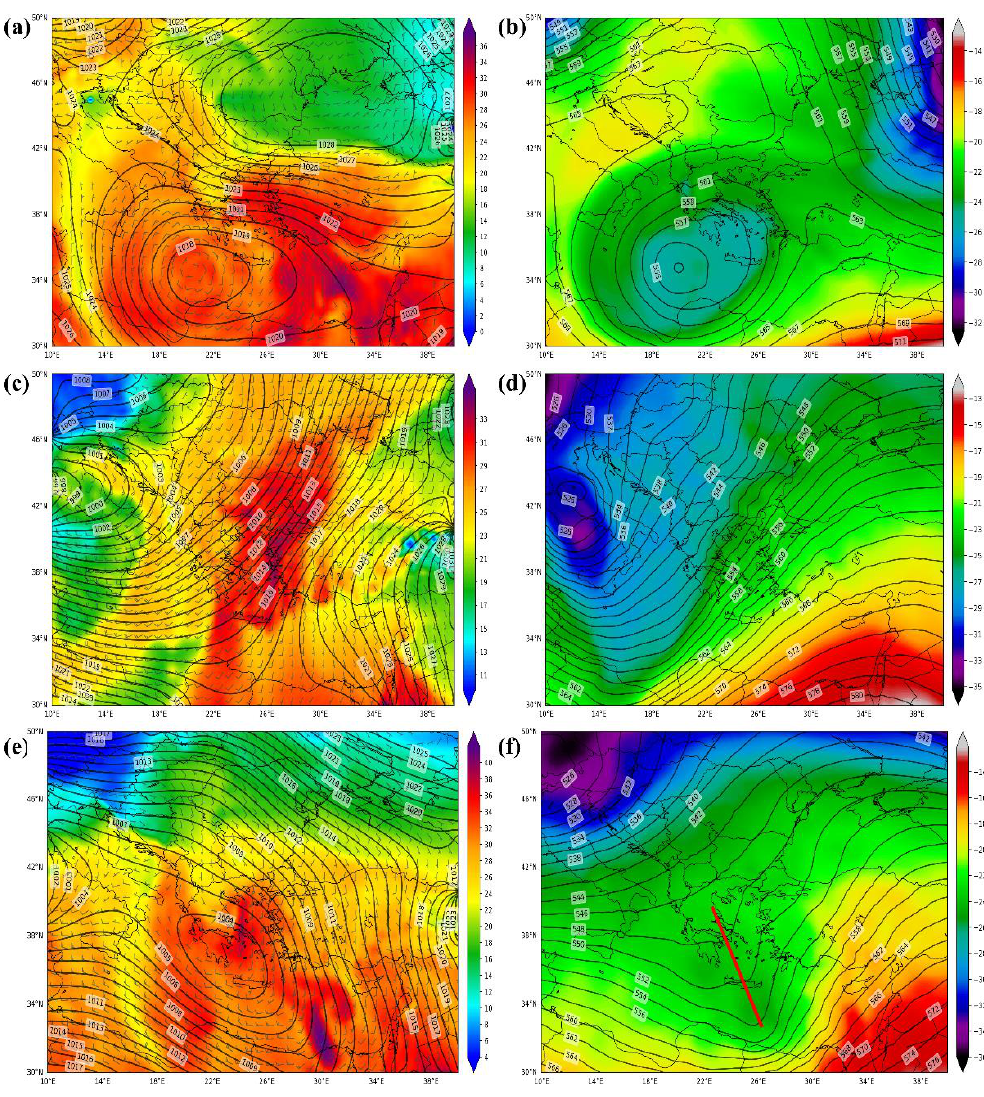
Figure 5. As in Figure 2 but for 30 December 2012, 0900 UTC ( a , b ), 16 January 2013, 0900 UTC ( c , d ), and 22 February 2013, 0800 UTC ( e , f ). The red line in map ( f ) indicates the negatively tilted trough axis.